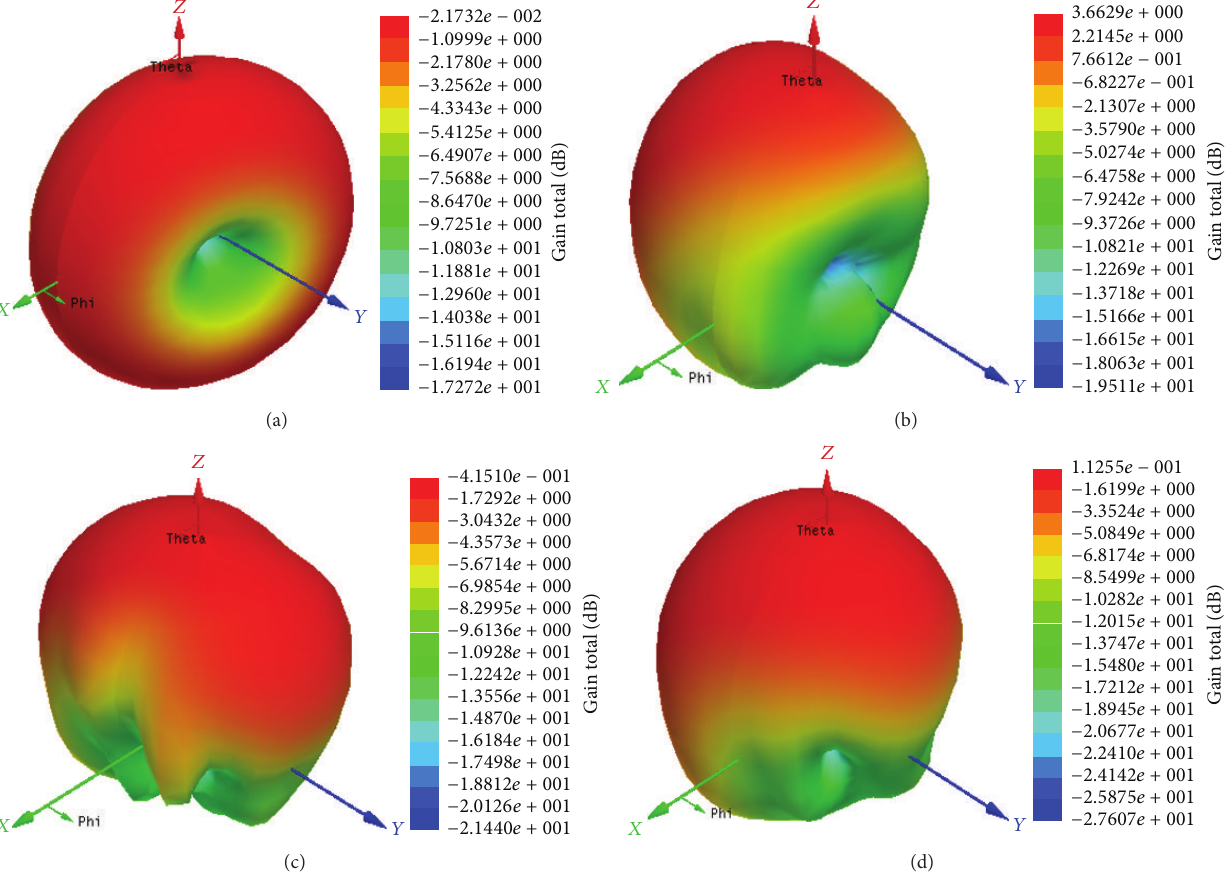
Figure 7: Simulated 3D Gain: (a) 0.92 GHz, (b) 1.8 GHz, (c) 2.1 GHz, and (d) 2.6